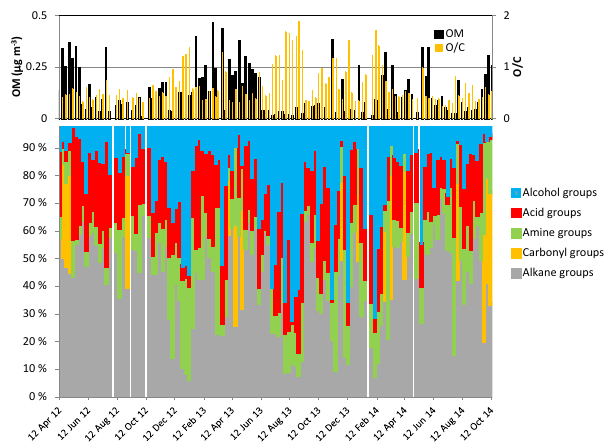
Figure 4. Time series of weekly-averaged OM and O / C (top panel) and percent contributions of the functional groups to OM (bottom panel).